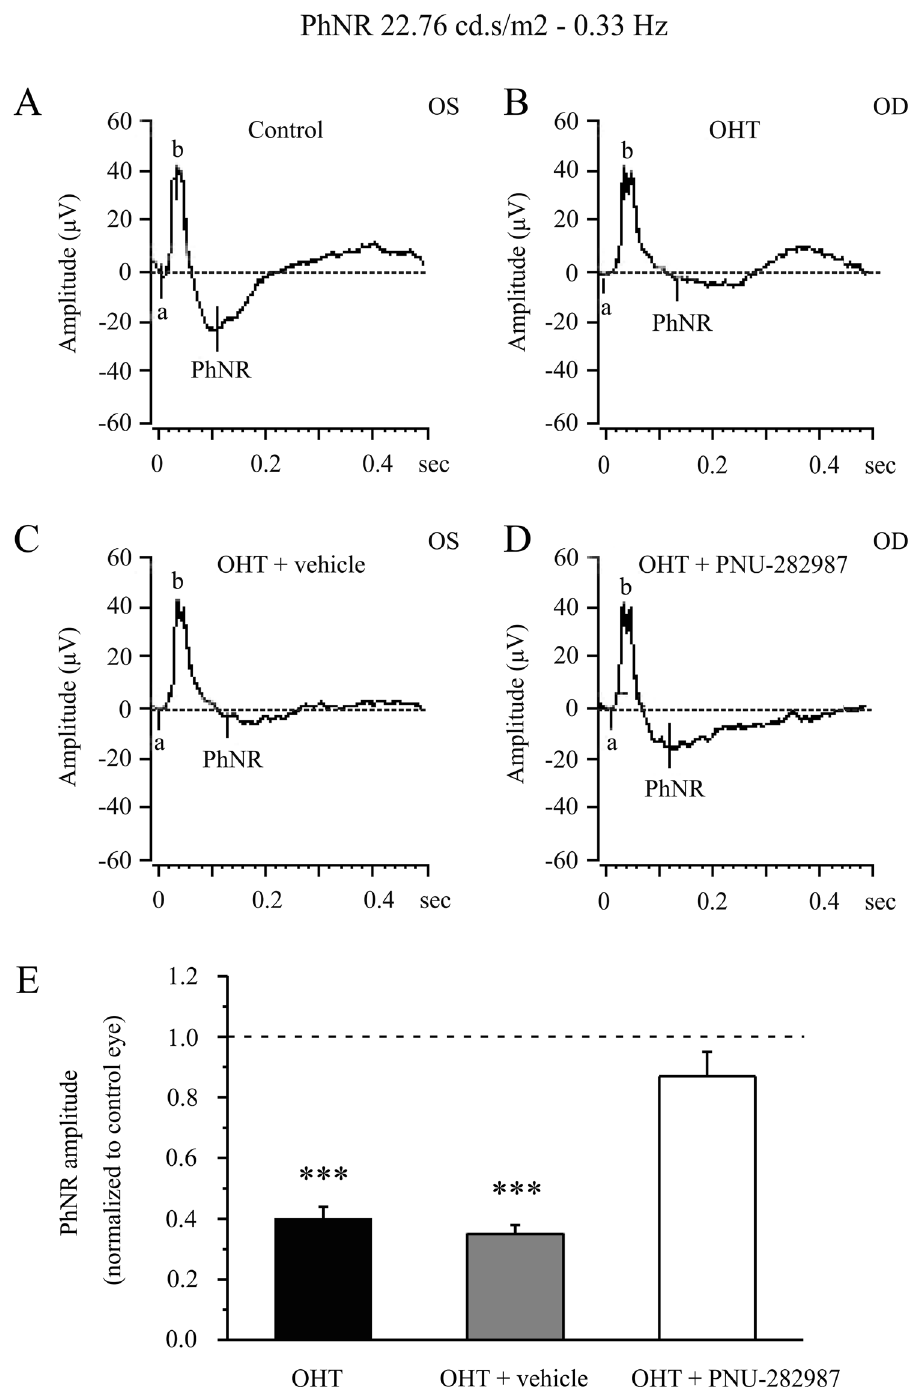
Figure 3. PhNR of normal and glaucomatous rat eyes. ( A,B ) Representative traces of the “a” wave, the “b” wave, and PhNR in a control eye (OS) and a glaucomatous eye (OD) at step 3 with the stimulus applied at 22.76 cd.s/ m 2 –0.33 Hz. ( C,D ) Representative waves in a vehicle-treated glaucomatous eye (OS) and a PNU-282987- treated glaucomatous eye (OD) at the same step and stimulus used in ( A,B ). ( E ) Quantitative analysis of PhNR amplitude ( n = 8). The amplitude was normalized to the amplitude in control retinas. *** p < 0.001 (one-way analysis of variance). The results in E are expressed as the mean ± SE. a, “a” wave; b, “b” wave; OHT, ocular hypertension; PhNR, photopic negative